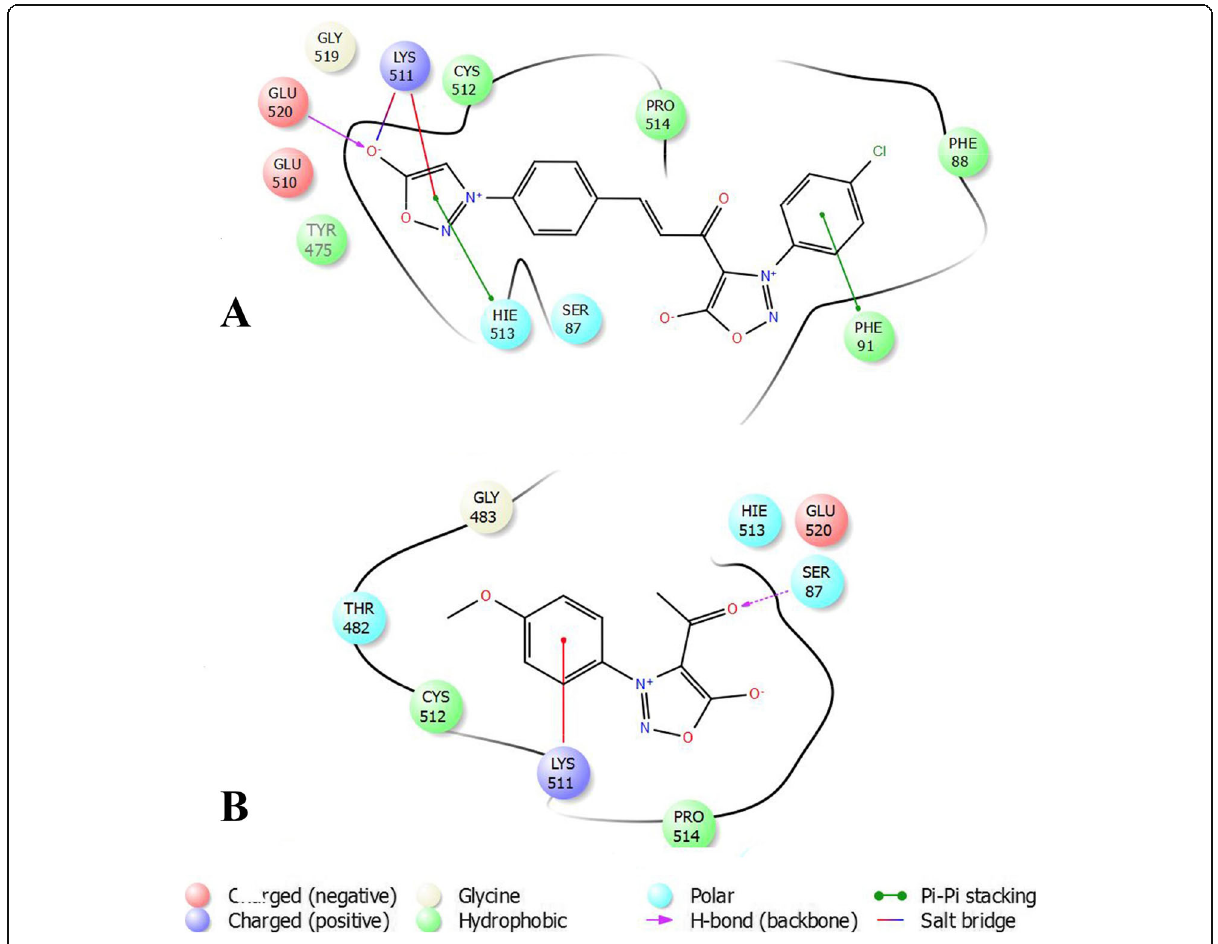
Fig. 7 Binding pose of 63 ( a ) and 51 ( b ) with the active site of